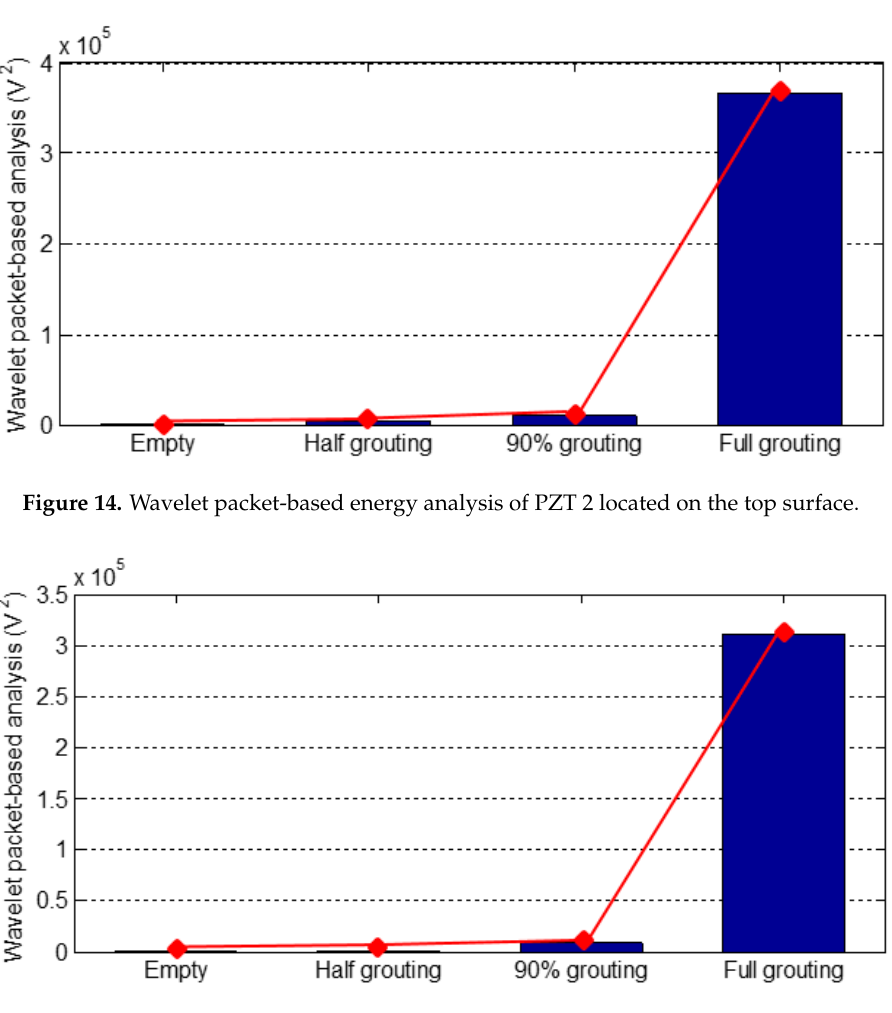
Figure 15. Wavelet packet-based energy analysis of PZT 3 located on the top surface.